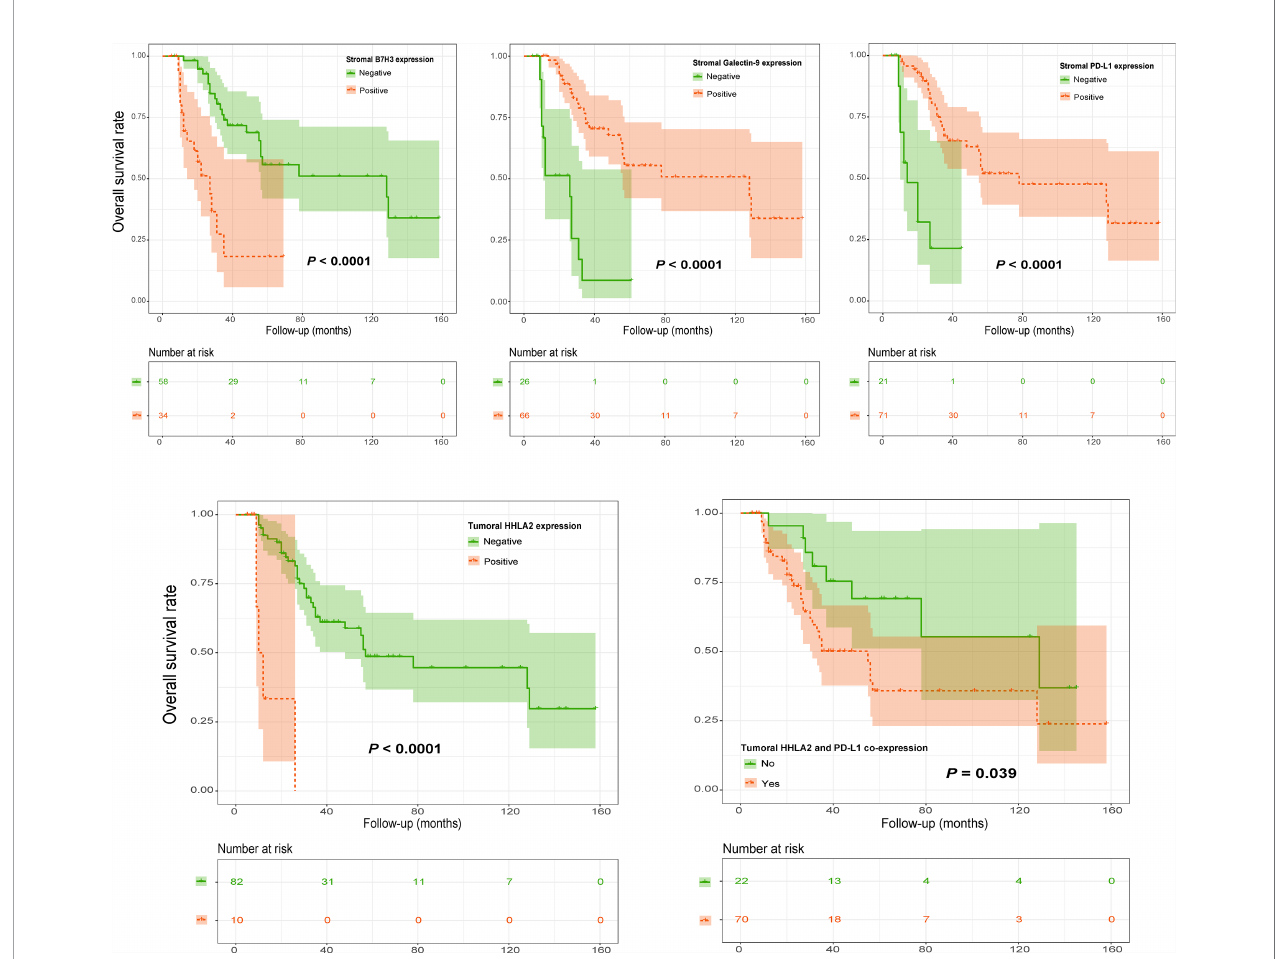
FIGURE 11 | Kaplan – Meier curves of OS of spinal chordoma patients strati fi ed by marker expression and coexpression status. OS, overall